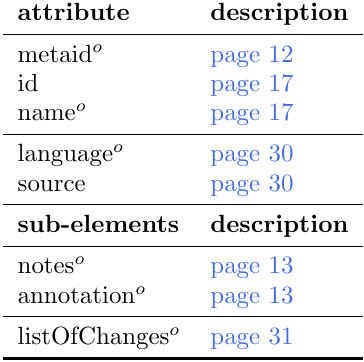
Table 2.9: Attributes and nested elements for model. o denotes optional elements and attributes.